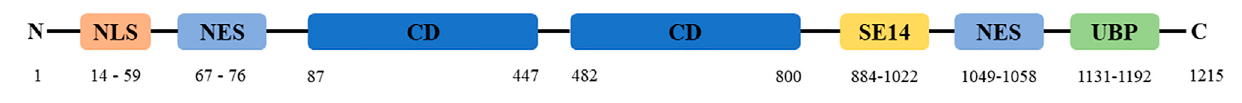
FIGURE1| Structure ofHDAC6. NLS,nuclearlocalizationsequence. CD, catalytic domains.NES,nuclear export signal.SE14,cytoplasmic retention signal.UBP, ubiquitin-binding zinc fi nger domain.